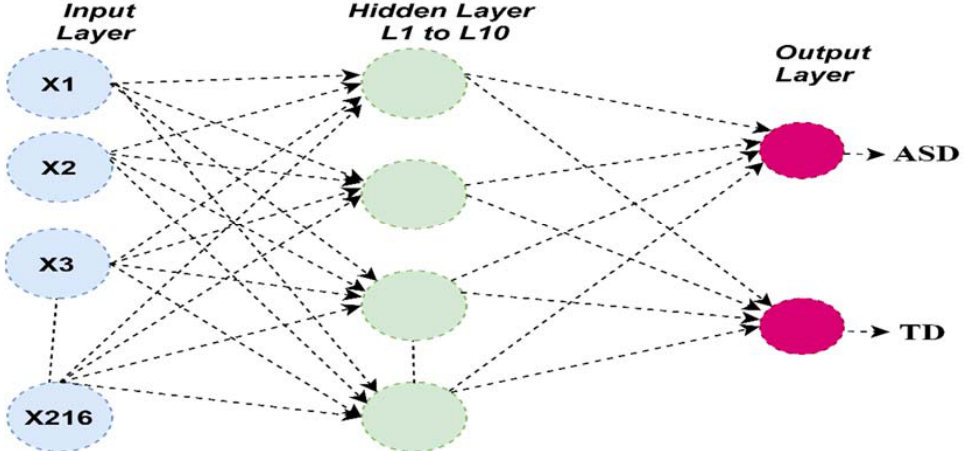
Figure 6. Architecture of the ANN and FFNN algorithms for ASD dataset.